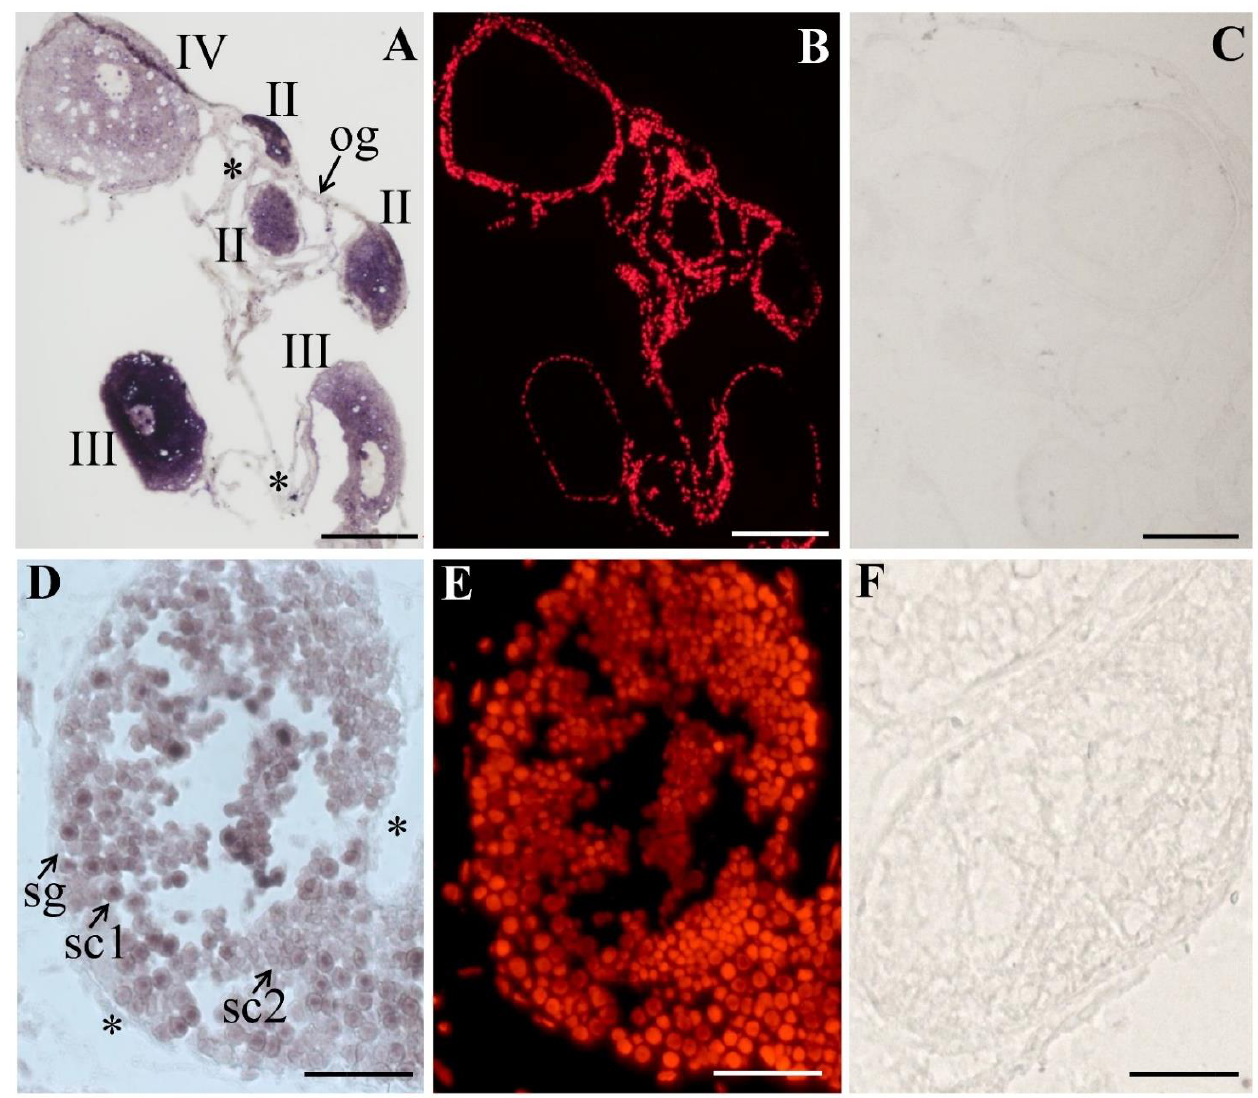
Figure 4. The PsNanog mRNA expression in ovary and testis by chemical in situ hybridization (CISH). CISH was performed on gonadal sections. The signal was in purple stained by Alkaline phosphatase (AP) ( A , D ), and the nucleus was stained with propidium iodide (PI) in red color ( B , E ). Sense probe as a negative control had no signals ( C , F ). PsNanog mRNA was expressed in primary oocytes. In the primary oocytes, the signal was strongest and uniformly distributed in the cytoplasm, and then the signal was concentrated in the cytoplasm of perinuclear region in the growing oocytes and gradually weakened with the growth of oocytes. Og, oogonia; stage II–IV, primary oocytes. PsNanog mRNA was expressed in spermatogonia (sg), primary spermatocyte (sc1), secondary spermatocyte (sc2). Somatic cells were labeled with stars. Scale bars, 50 µ